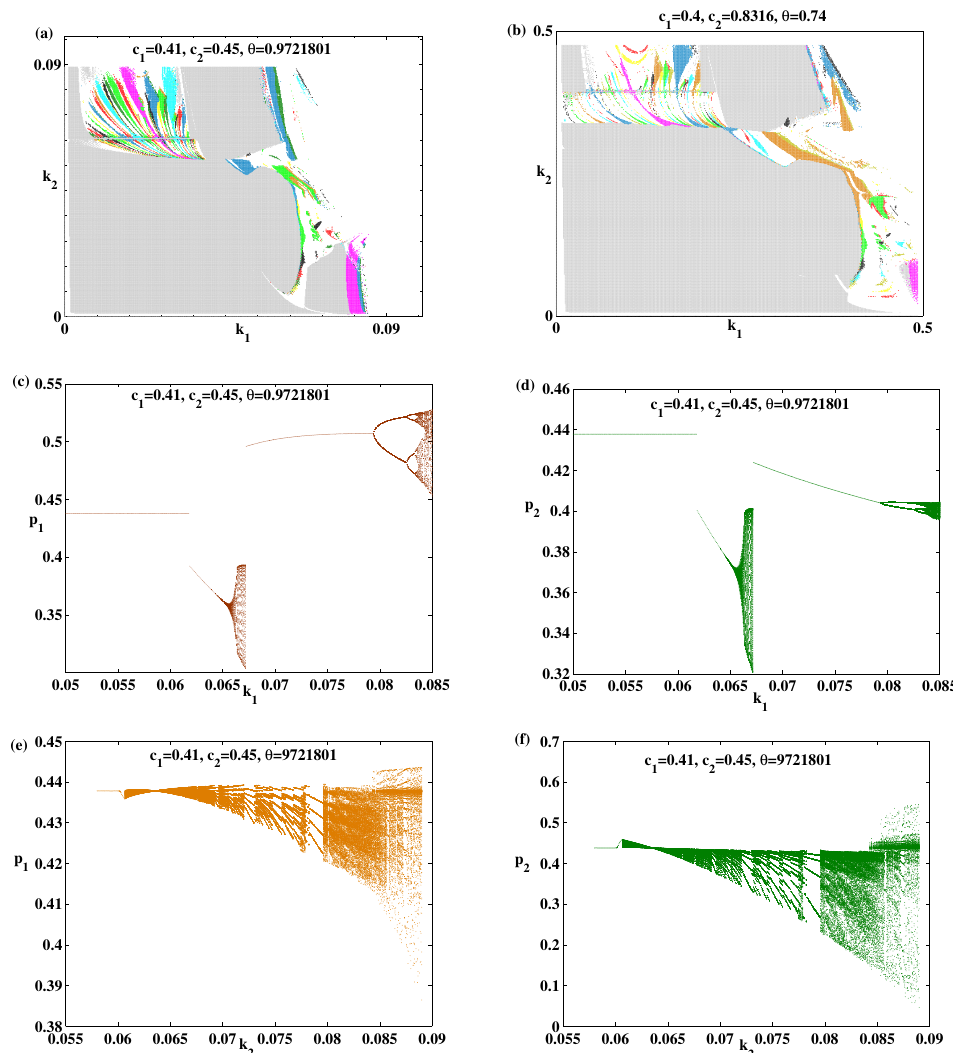
Figure 1. ( a , b ) 2D bifurcation diagram of the system in the ( k 1 , k 2 ) parameter plane. The light gray color refers to the stability region of the fixed point. Other colors are for different types of period cycles. The white color refers to the non-convergent points. ( c , d ) Bifurcation diagrams with respect to p 1 and p 2 on varying k 1 at: c 1 = 0.41, c 2 = 0.45, θ = 0.9721801 and k 2 = 0.006. ( e , f ) Bifurcation diagrams with respect to p 1 and p 2 on varying k 2 at: c 1 = 0.41, c 2 = 0.45, θ = 0.9721801 and k 1 =